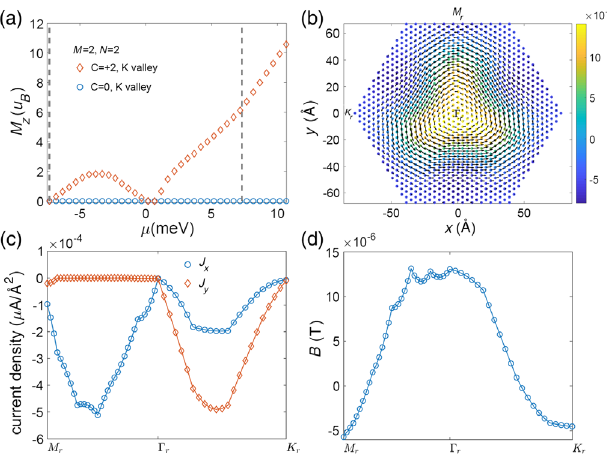
FIG. 7. (a) The orbital magnetization M of the two flat bands z of the K valley for ( 2 þ 2 )-layer twisted graphene at the first magic angle. The red diamonds (blue circles) represent the situation that the stacking chiralities are opposite (the same), with the Chern number þ 2 (0). The horizontal axis is the chemical potential μ . The vertical dashed lines mark the bulk band edges of the two low-energy flat bands. (b) The real-space distributions of the current density (black arrows) and the current- induced magnetic field (color coding) within the moir´e supercell. The AA region is centered at the origin. (c) Current densities − Γ − K plotted along the real-space path M , where the M , r r r r Γ , and K points are marked in (b). (d) The local magnetic field r r − Γ − K plotted along M r r r